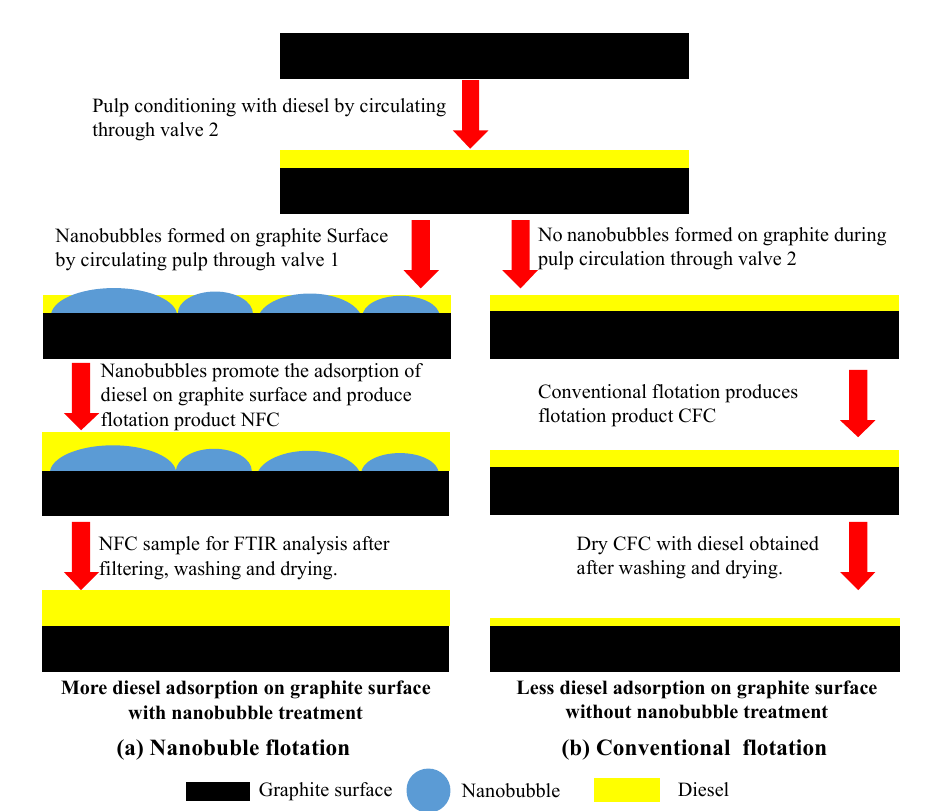
Figure 14. Illustration of effects of surface nanobubbles on entire flotation process of